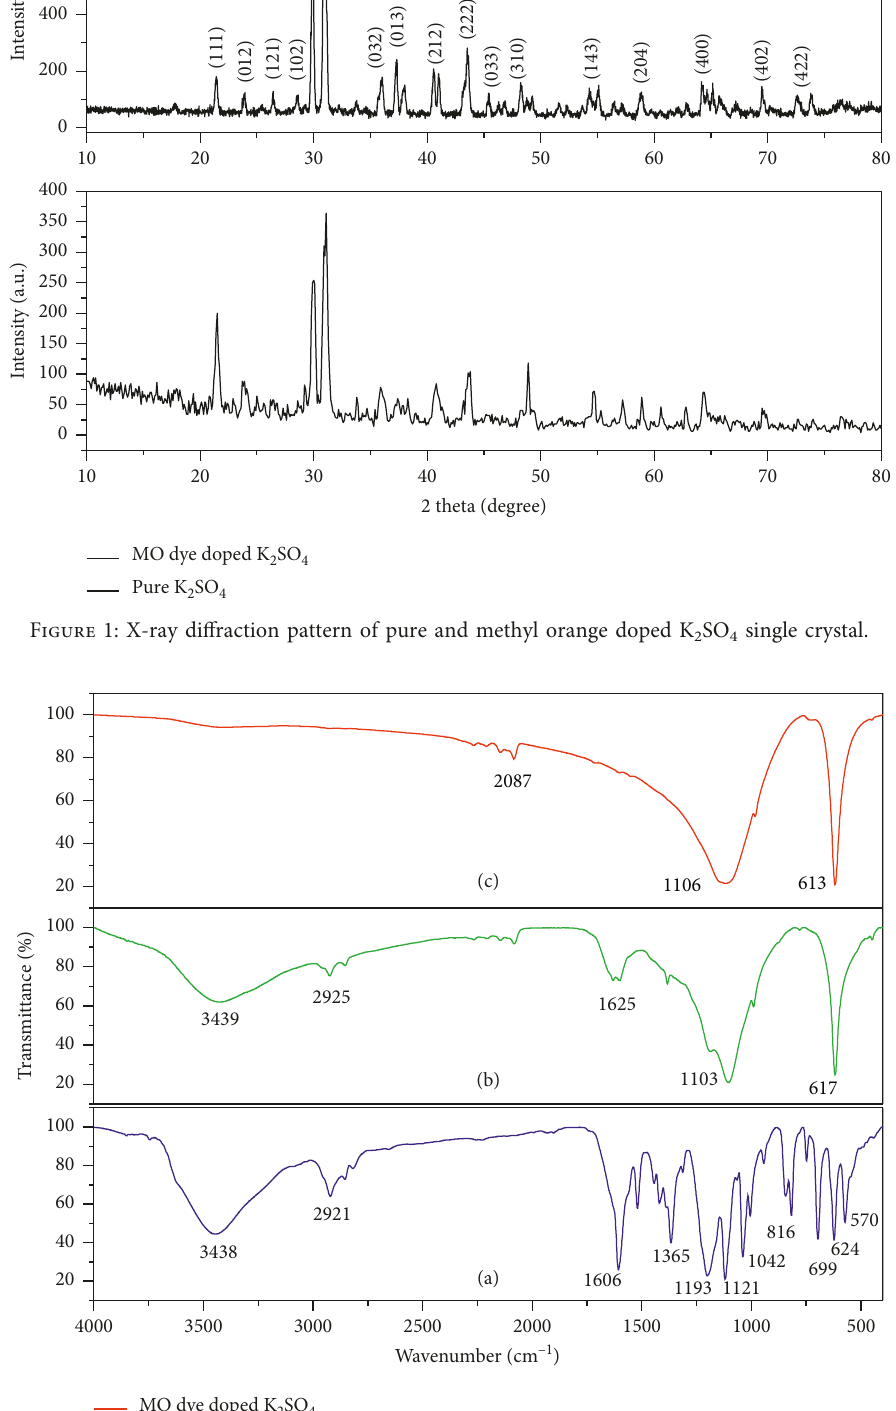
Figure 2: FTIR Spectra of pure MO dye, pure K2SO4, and MO dye dopped K2SO4 single crystal. (a) MO dye, (b) K2SO4, and (c) MO dye dopped K2SO4 single